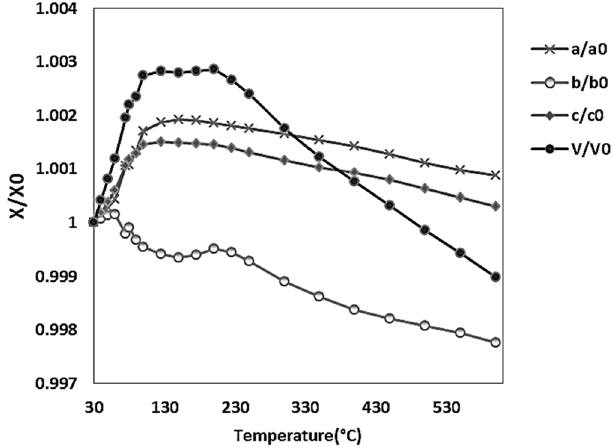
Figure 3. Temperature evolution of ZSM-5-MTBE unit cell parameters during in situ thermal organic burning. All values are normalized compared to those refined at room temperature.